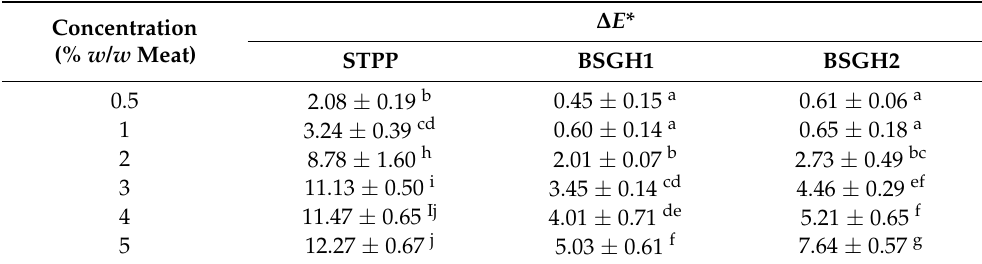
Table 5. Color differences ( ∆ E *) in cooked chicken meat samples with different BSGH1, BSGH2, or STPP concentrations. Results are presented as the average of three replicates ± standard deviation. Different letters indicate significant differences ( p ≤